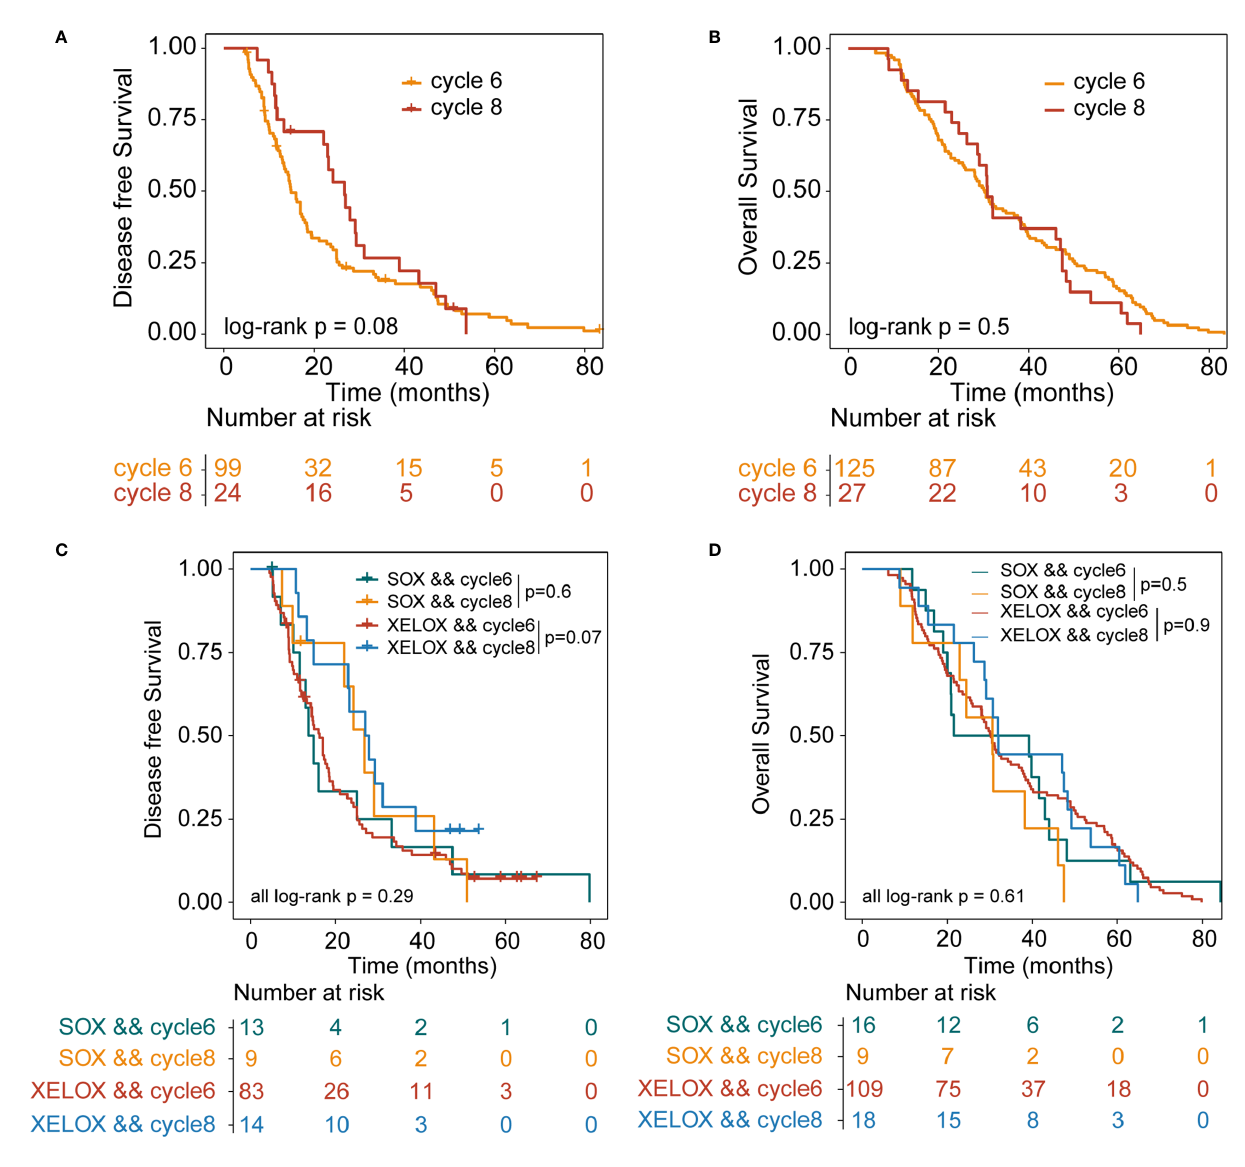
FIGURE 1 | Kaplan-Meier survival curves for disease-free survival (DFS) and overall survival (OS). DFS (A) and OS (B) analyses for stage II and stage III patients who received six or eight cycles of chemotherapy, irrespective of whether they underwent XELOX or SOX regimens. DFS (C) and OS (D) analyses for stage II and stage III patients who received six or eight cycles of chemotherapy, taking the speci fi c regimen into account. XELOX, Capecitabine plus oxaliplatin; SOX, S-1 plus